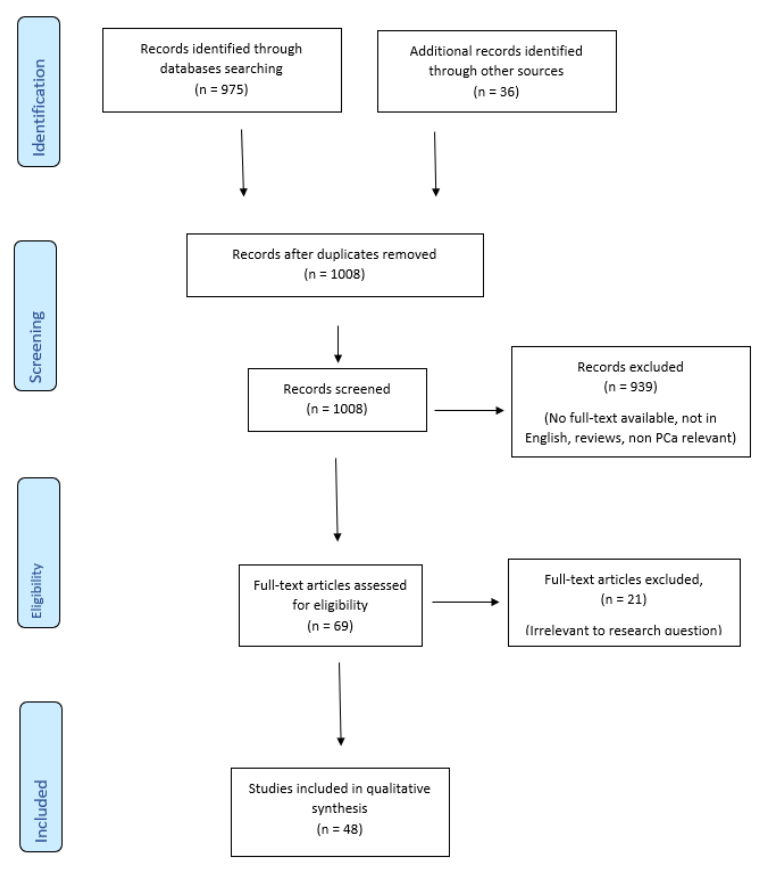
Figure 2. Summary of study selection process.